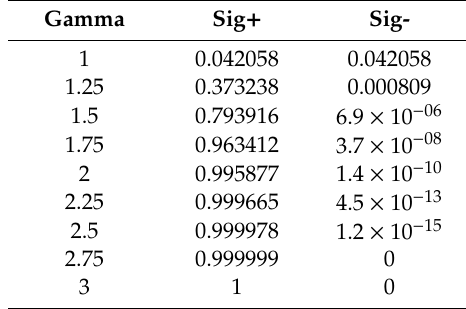
Table 5. Sensitivity analysis